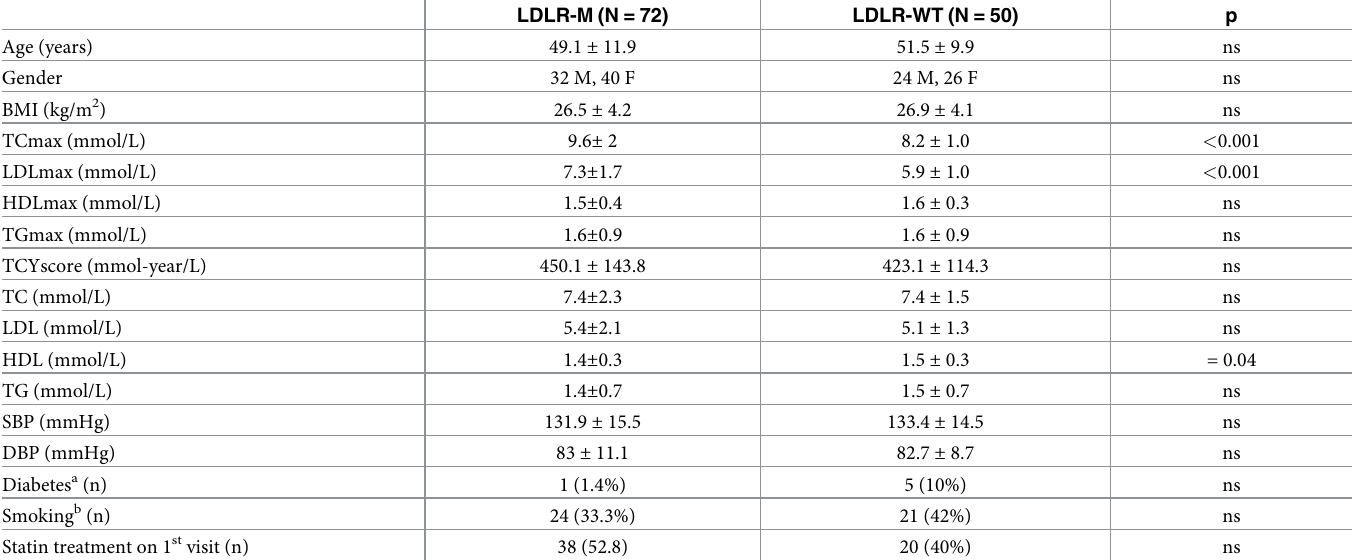
Table 1. Clinical characteristics of LDLR-M and LDLR-WT groups.